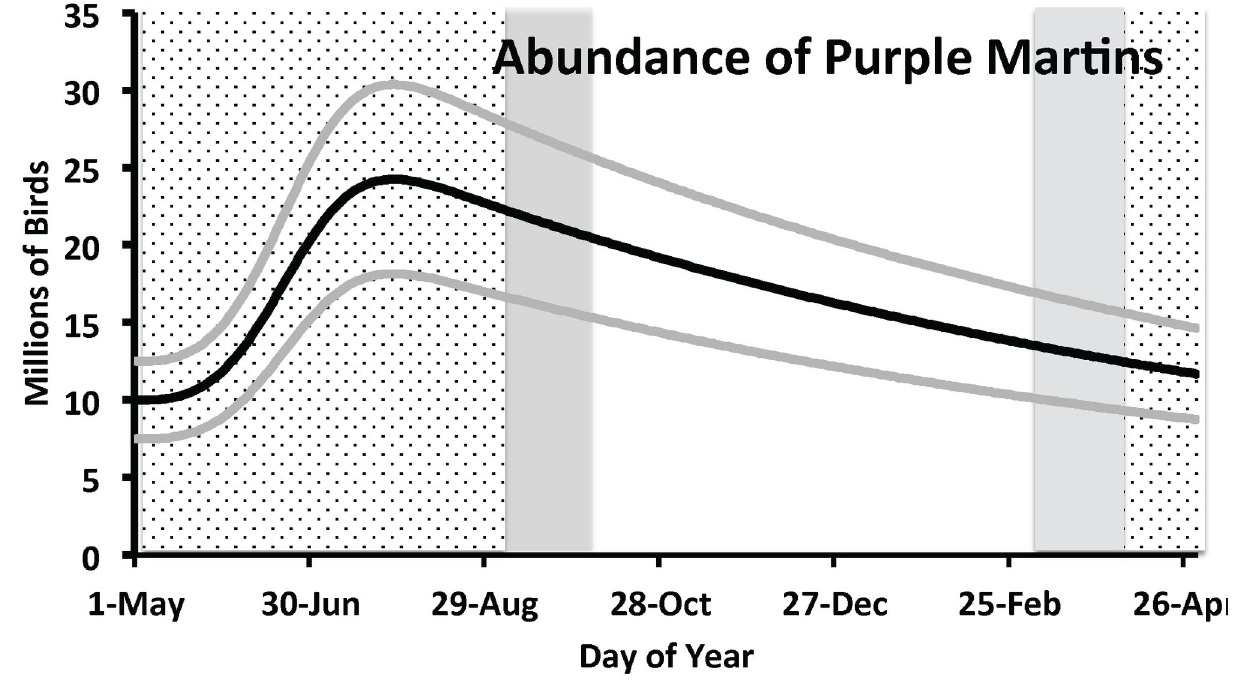
Figure 2. Estimated mean number (black line) ± standard deviation (gray lines) of Purple Martins based on 10,000 replications of a demographic simulation model. Background shading indicates phase of the annual cycle as breeding season (stippling), migration (gray), and winter (no